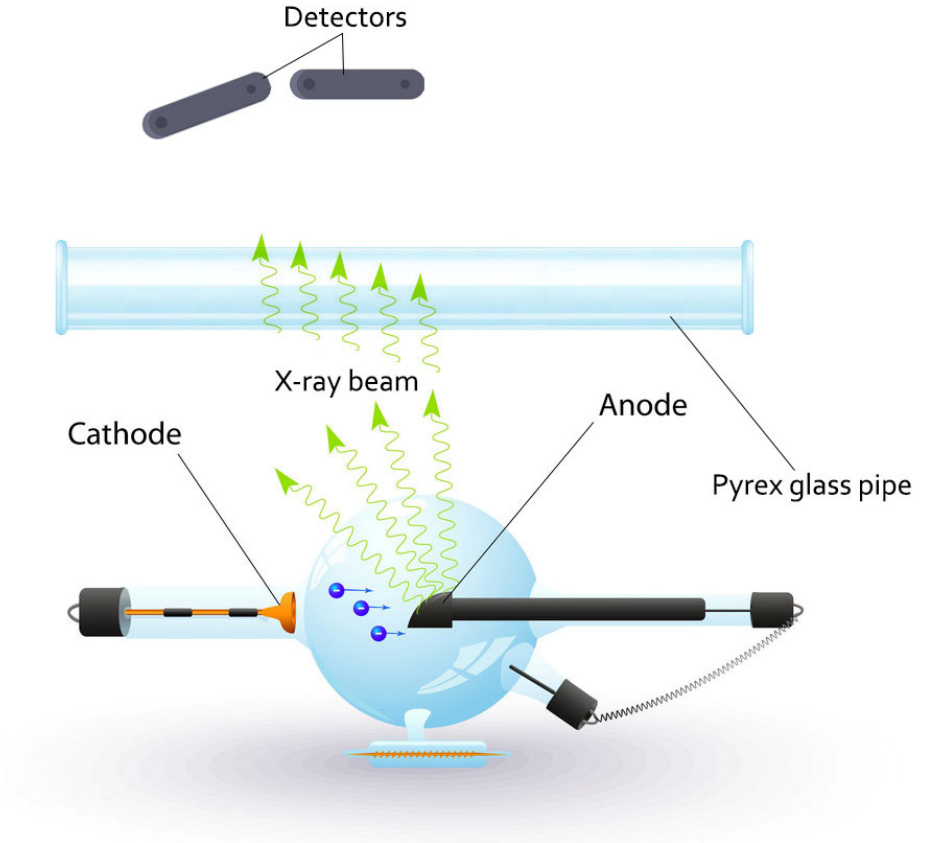
Figure 2. Proposed detection system structure.